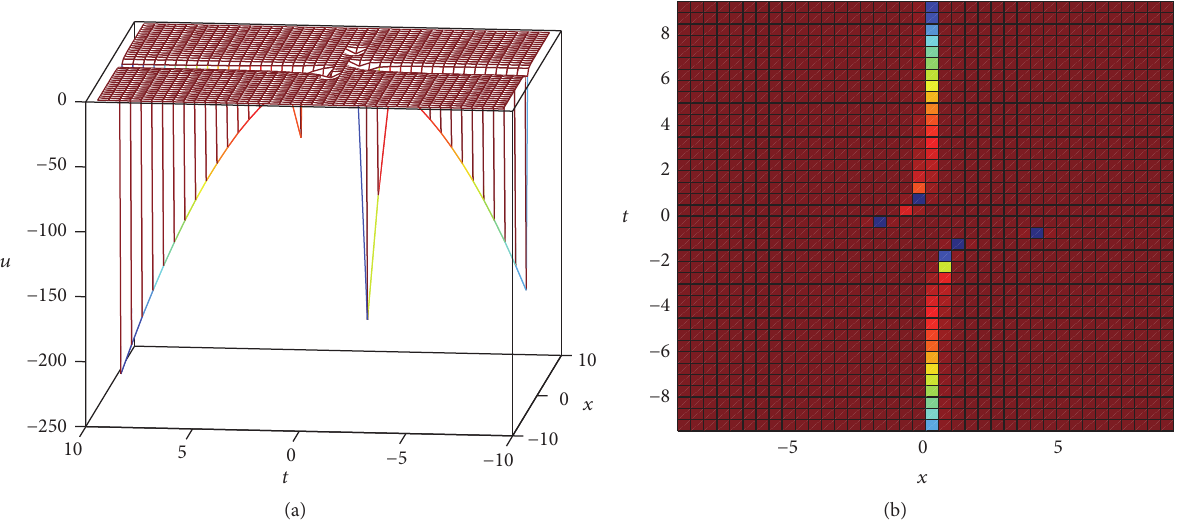
Figure 3: Pictures of (20): 3D plot (a) and density plot